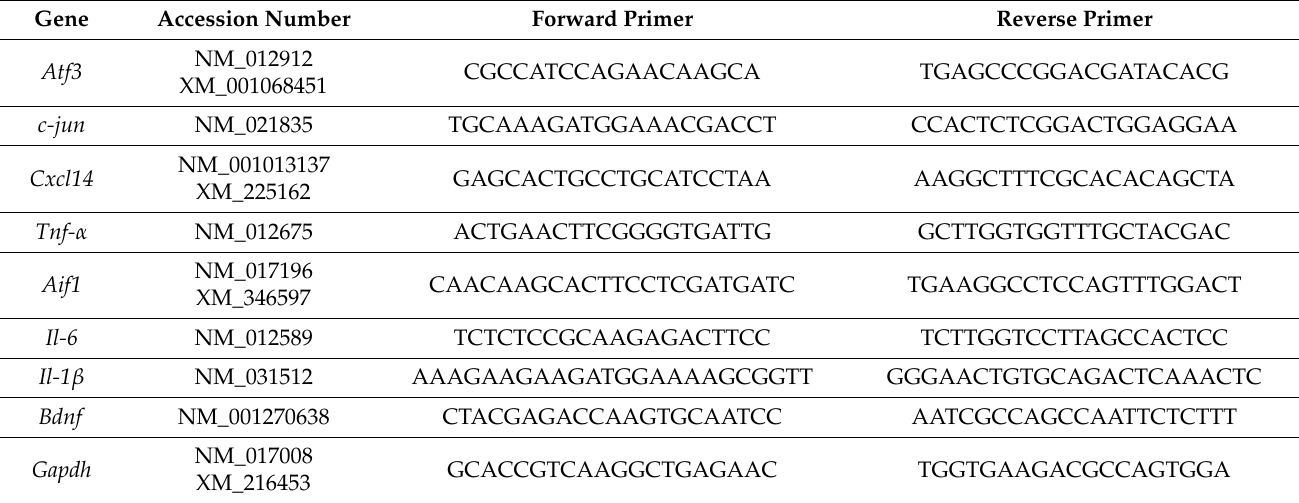
Table 1. Primer sequences for